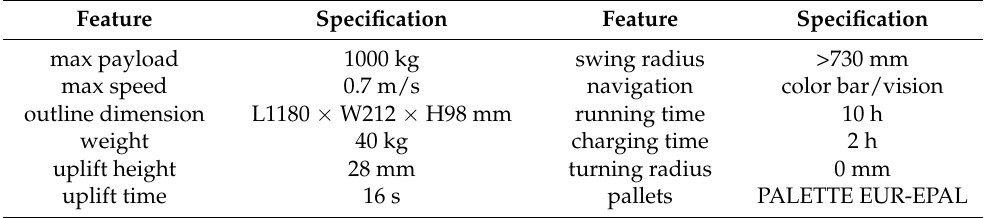
Table 1. The specifications of the master-slave separate parallel intelligent mobile